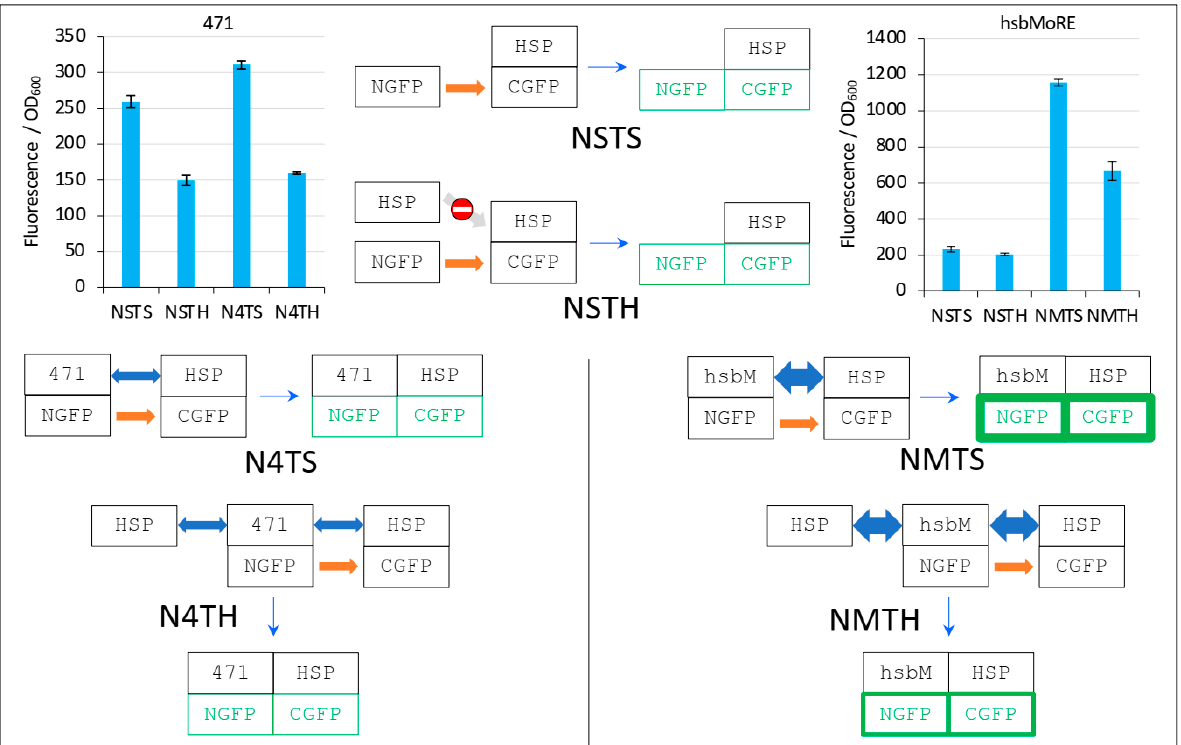
Figure 10. Explanation of Figure 9 results. The two top left and right bar plots are fluorescence data obtained by using 471 and hsbMoRE, respectively. See Figure 6 for details and main text for a description of NSTS, NSTH, N4TS, and N4TH. The light grey arrow with a no-way symbol indicates an absence of interaction.